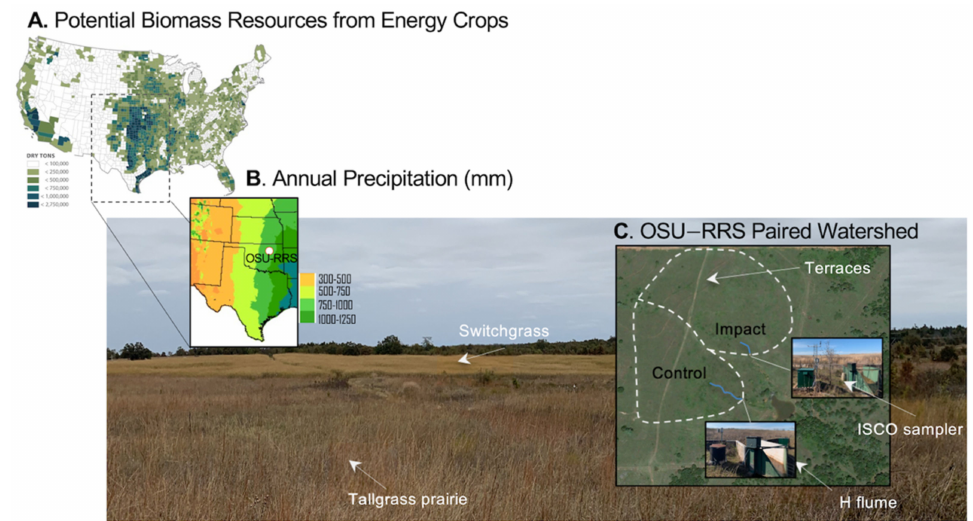
Figure 1. The southern Great Plains of the United States, which encompass Kansas, Oklahoma, and Texas: ( A ) The region that has the greatest potential biomass resources from energy crops in the United States adapted from the report by Union of Concerned Scientists [57]. A distinct precipitation gradient characterizes this region from over 1250 mm in the east to less than 500 mm in the west; ( B ) The study watersheds are located in the climate transition zone (750–1000 mm). Watershed boundaries were overlayed on a Google Earth image (2015) before the Impact Watershed was converted. Historic terraces are visible in the upper portion of both watersheds; ( C ) The watershed to the southwest was the Control Watershed, and the watershed to the northeast was the Impact Watershed, which was converted to a switchgrass production system in 2016. Runoff was gauged using USDA prefabricated H flumes and was subsampled for sediment analysis using the ISCO sampler (Model 3700C, Teledyne ISCO, Lincoln, NE,